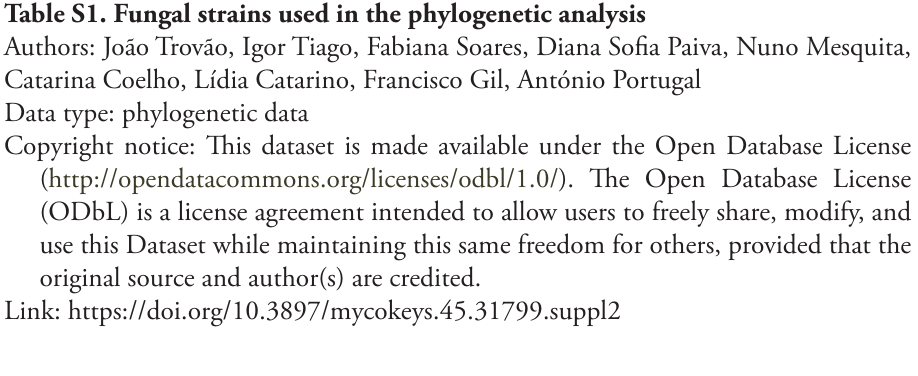
Table S1. Fungal strains used in the phylogenetic analysis